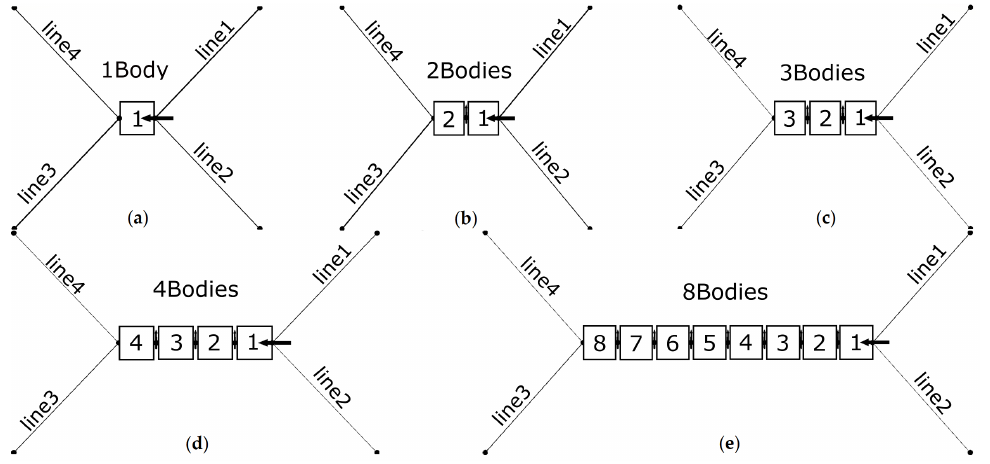
Figure 5. Layouts of the five test cases of the chain configuration for studying the sensitivity to the number of modules: ( a ) one-module case; ( b ) two-module case; ( c ) three-module case; ( d ) four-module case; ( e ) eight-module